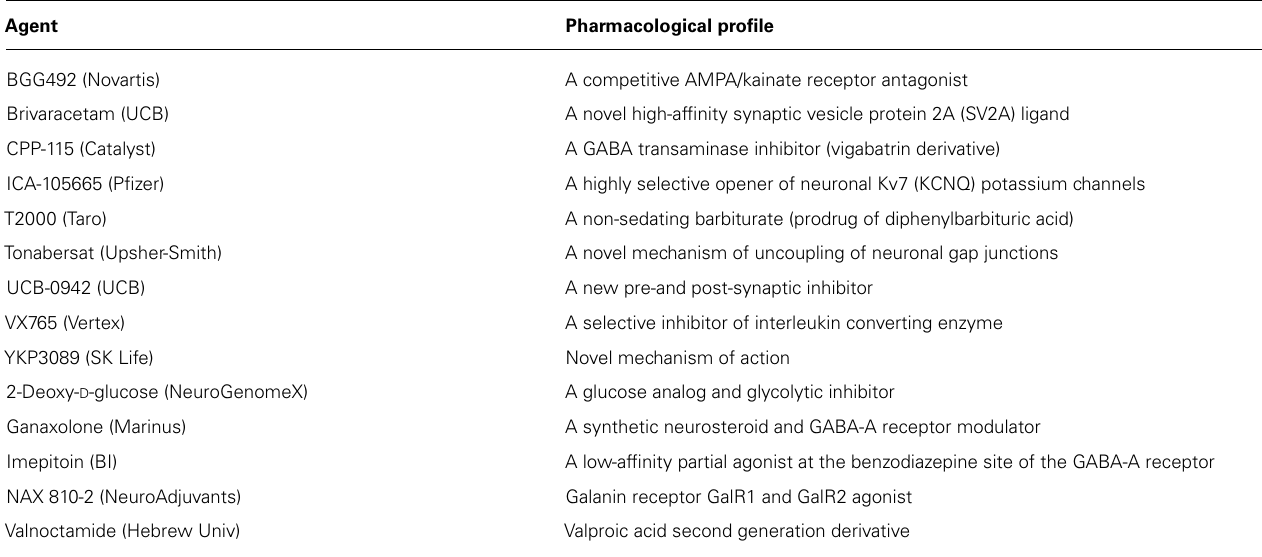
Table 5 | Pipeline of new drugs for epilepsy under